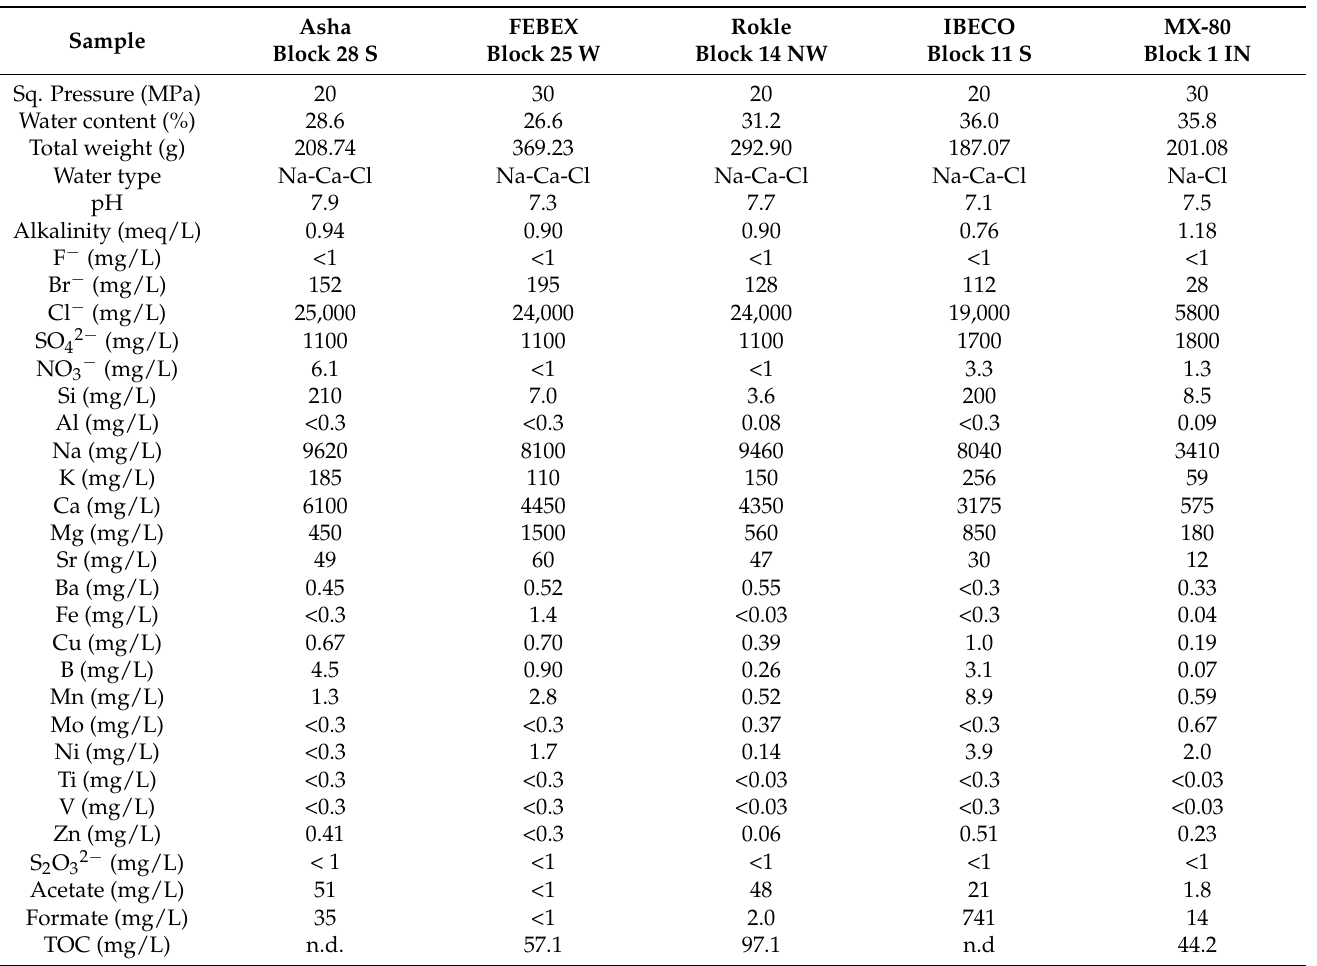
Table 11. Chemical composition of the pore water extracted from the AMB5 bentonite blocks (n.d.: non